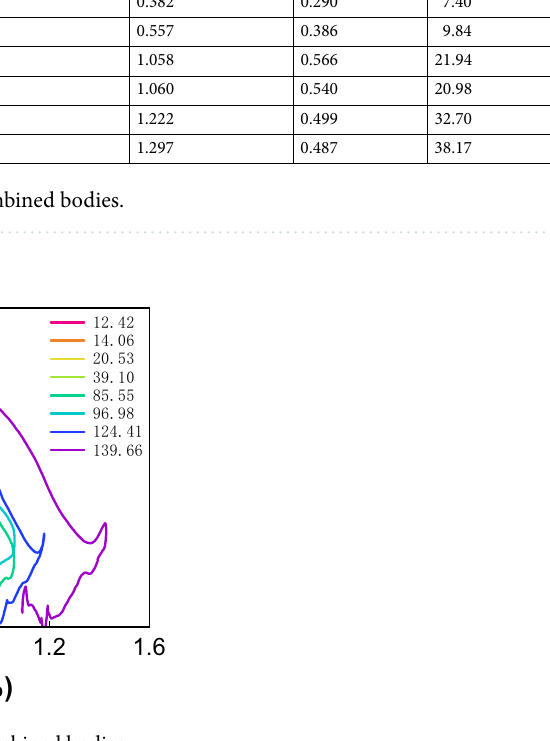
Figure 11. Stress–strain curve of combined